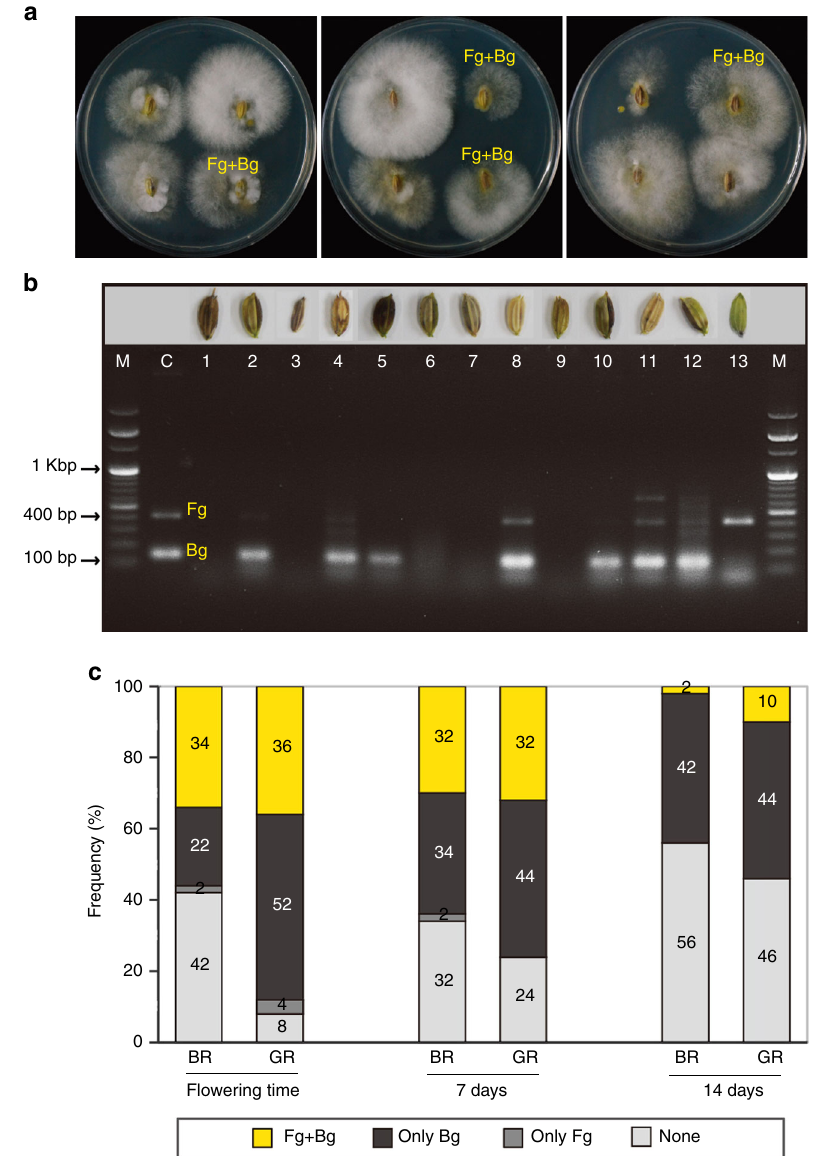
Fig. 1 Co-detection of Bukholderia glumae (Bg) and Fusarium graminearum (Fg) in rice fi elds. a Both Bg and Fg were isolated from surface-sterilised rice grains that were placed on PDA for 3 d. b Bg and Fg were detected with speci fi c primer pairs from diseased rice grains. Lane M, 100 bp marker; Lane C, positive control (Fg and Bg mixed DNA). c Coexistence frequencies of Bg and Fg in 50 rice grains collected at 7-d intervals beginning with the fl owering season from fi eld-grown black-type rice (BR) and glutinous-type (GR) rice were calculated. Bg and Fg were detected with speci fi c